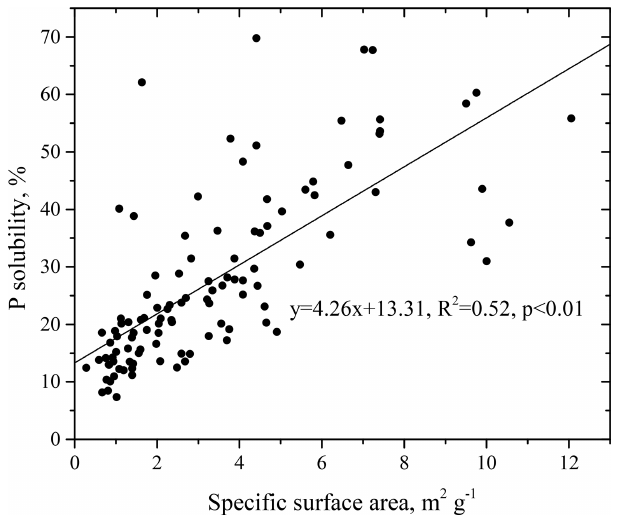
Figure 5. Relationships between P solubility and the specific sur- face area of